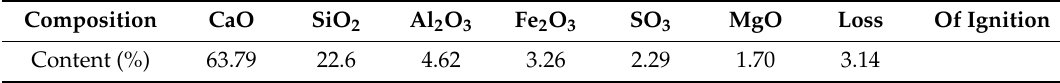
Table 1. Chemical composition of P.O 42.5R